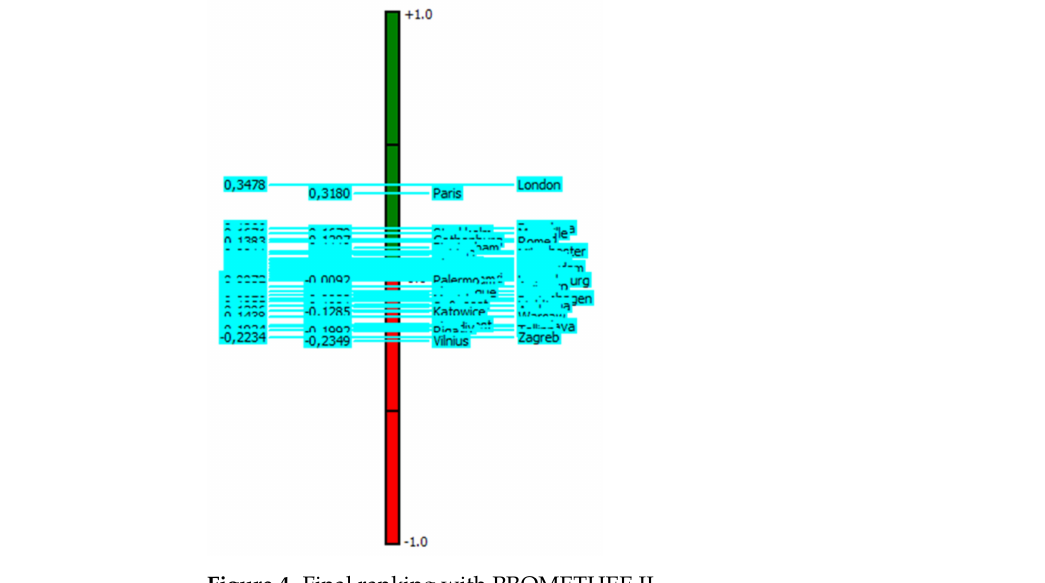
Figure 4. Final ranking with PROMETHEE II.